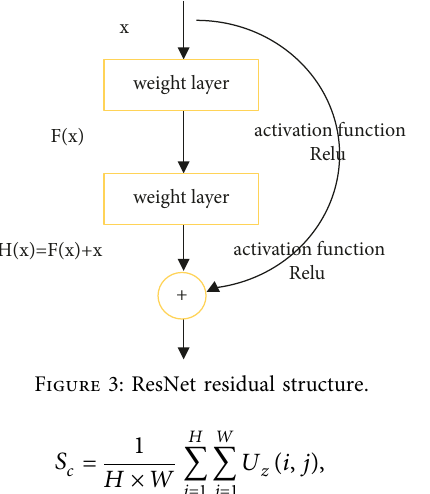
Figure 3: ResNet residual